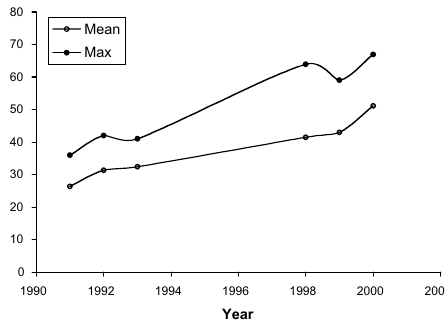
Fig. 6. Mean and maximum numbers of grey seals counted at Molène in Brittany, France since 1992. The rate of increase, as based on mean numbers, was 7% per